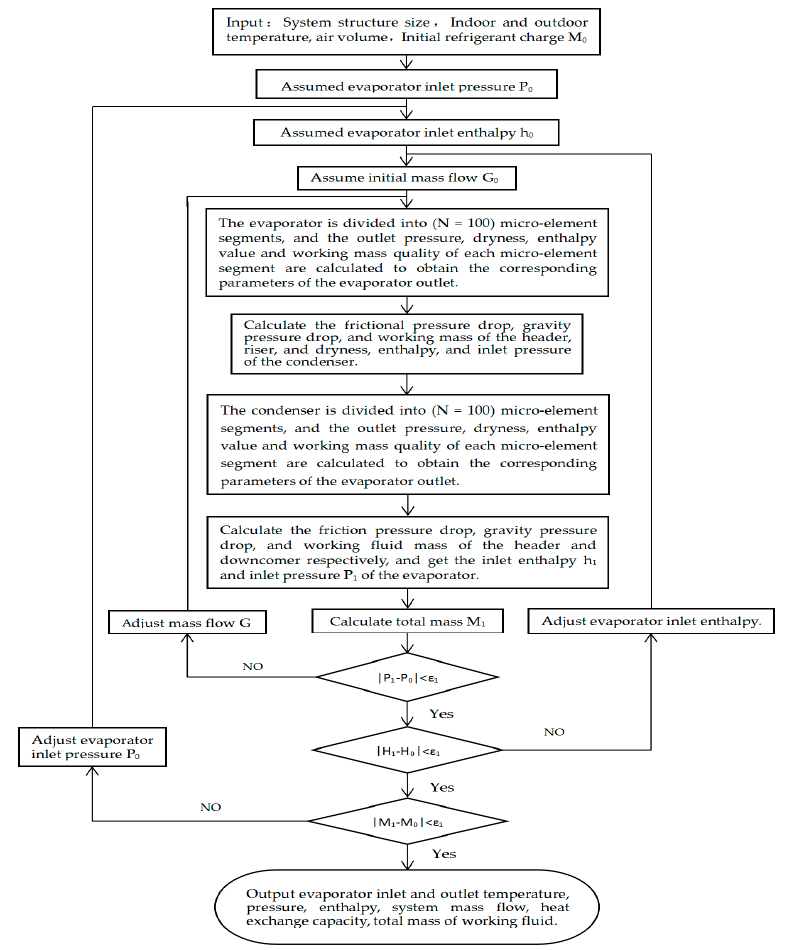
Figure 4. Flow chart of steady-state heat transfer calculation for the micro-channel backplane heat pipe system.